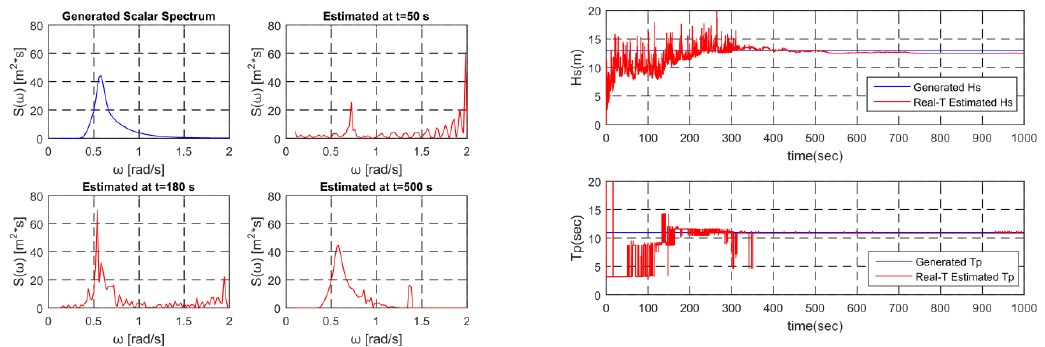
Figure 28. Generated and estimated spectrum / Evolution of parameters (Sea sate 7, Hs = 13 m, Tp = 11 s).